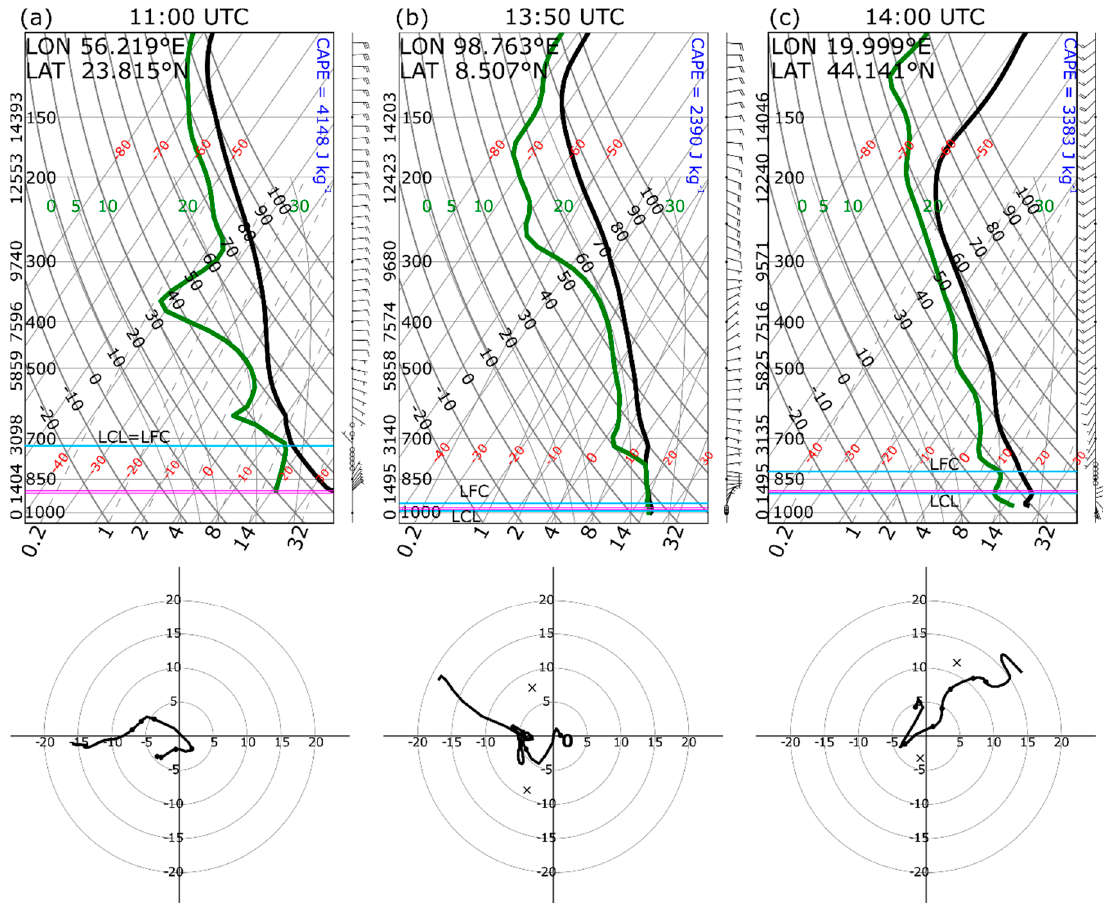
Figure 7. Modelled skew- 𝑇 –log 𝑃 diagrams for ( a ) UAE ( b ) Thailand and ( c ) Serbia. Time and location of profiles shown in each plot. The thick black and green lines are the vertical profiles of temperature and dew point, respectively. Heights of significant pressure levels are given in the ordinate (in m). The lifted condensation level (LCL) and the level of free convection (LFC) are shown with blue lines. The values of model-estimated convective available potential energy (CAPE) are also included in the plots. The seeding layers shown with horizontal pink lines (~100 m deep).